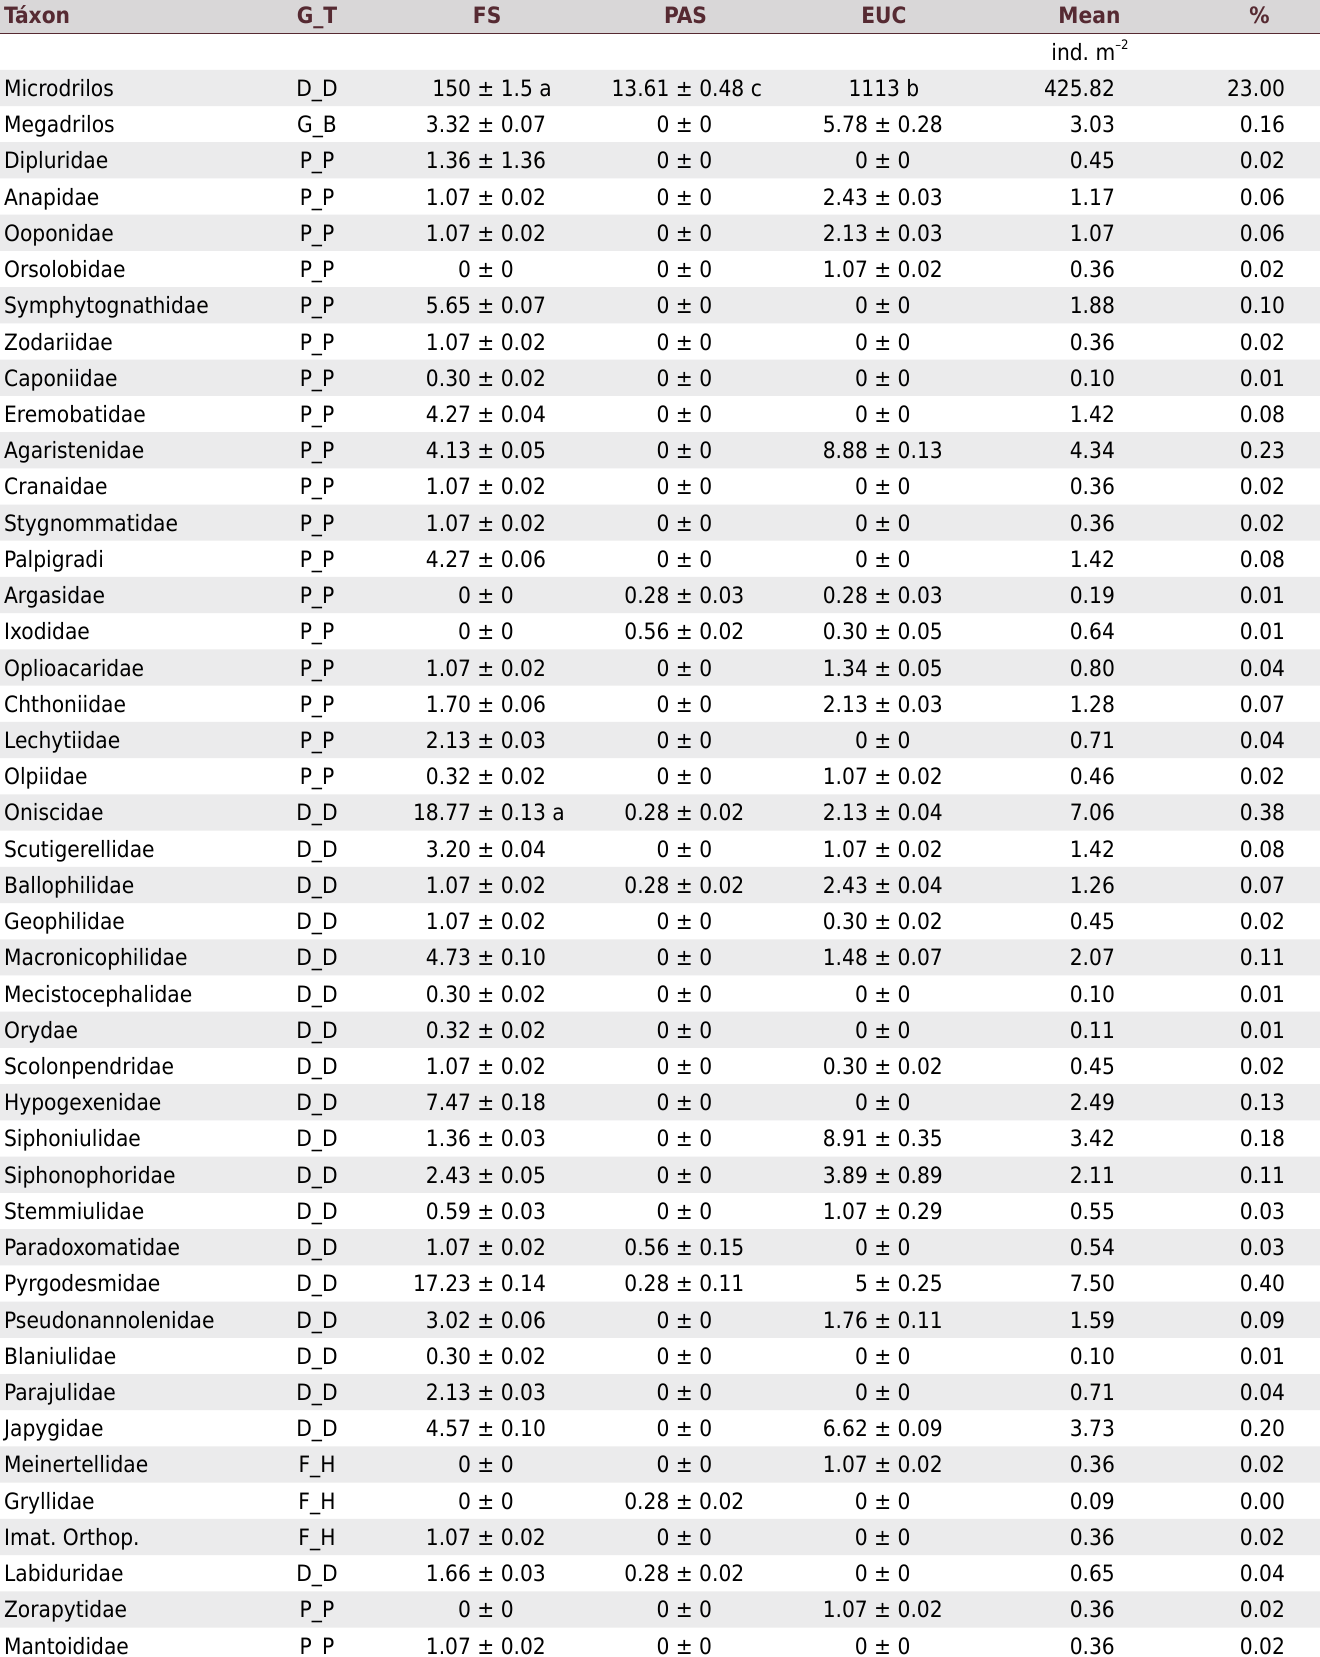
Table 1. Mean density of the edaphic macrofauna in the 40-year Secondary Forest (FS), 20-year Pasture (PAS), and 10-year Eucalyptus (EUC) in Marabá – Pará, Brazil